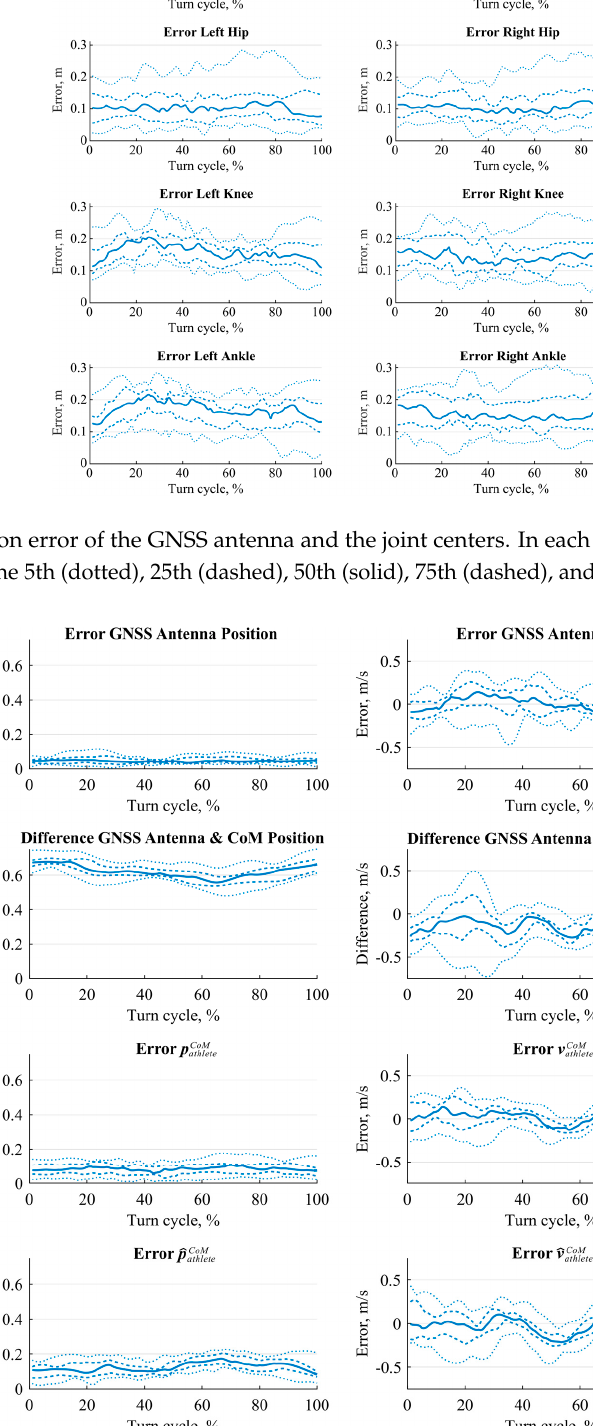
Figure 6. GNSS antenna position, speed and athlete CoM position, speed differences and errors. In each graph the lines are, from bottom to top, the 5th (dotted), 25th (dashed), 50th (solid),